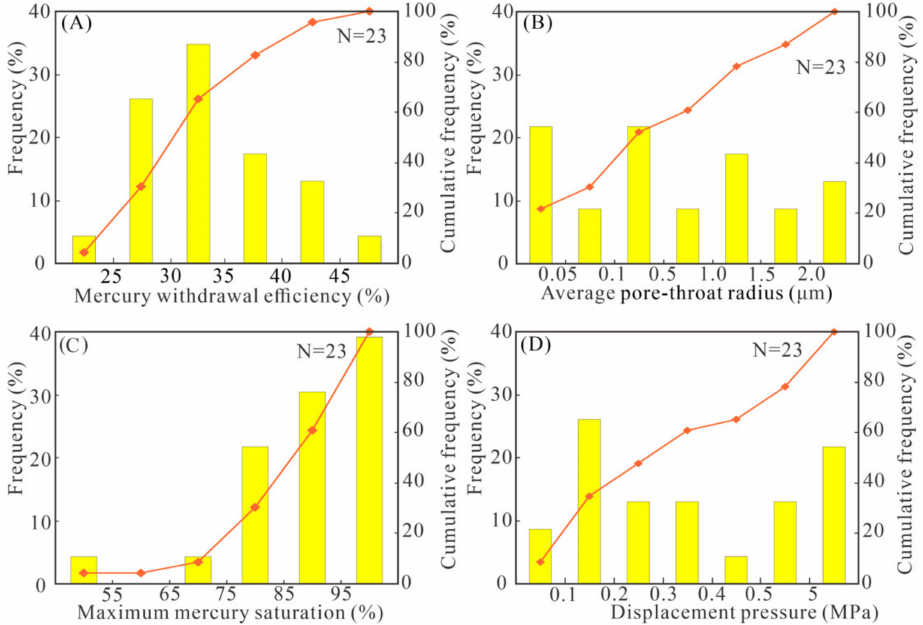
Figure 6. Distribution of mercury withdrawal efficiency ( A ), average pore throat radius ( B ), maximum mercury saturation ( C ), and displacement pressure ( D ) for 23 sandstone